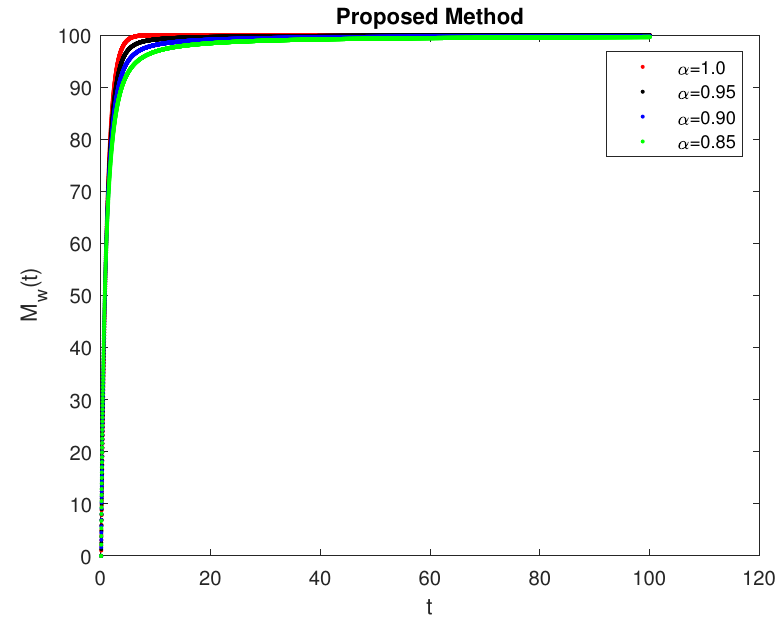
Figure 15: Numerical simulations for τ = 0.98 for Caputo derivative.